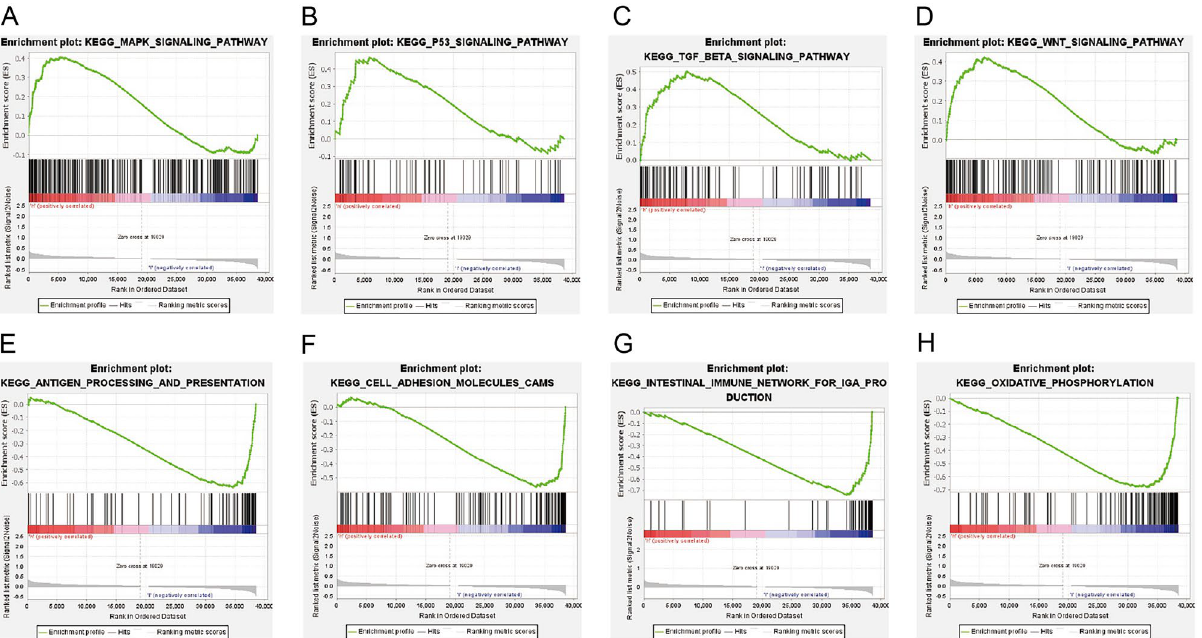
Figure 11. Enrichment plots from the gene set enrichment analysis. ( A – D ) Signaling pathways enriched in the high-risk CESC samples; ( E – H ) Biological processes enriched in the low-risk group of CESC